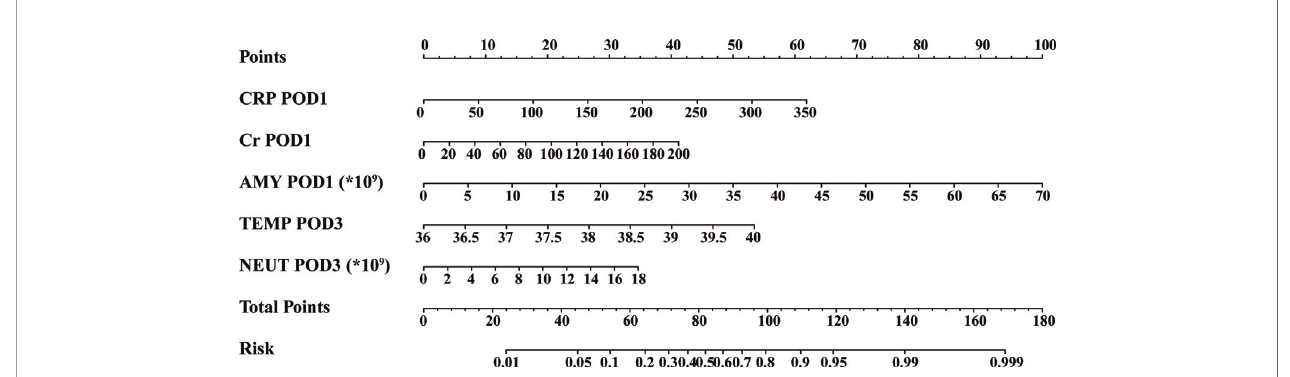
FIGURE 2 | Predictive nomogram for the probability of clinically relevant postoperative pancreatic fi stula. *, a multiplication sign.